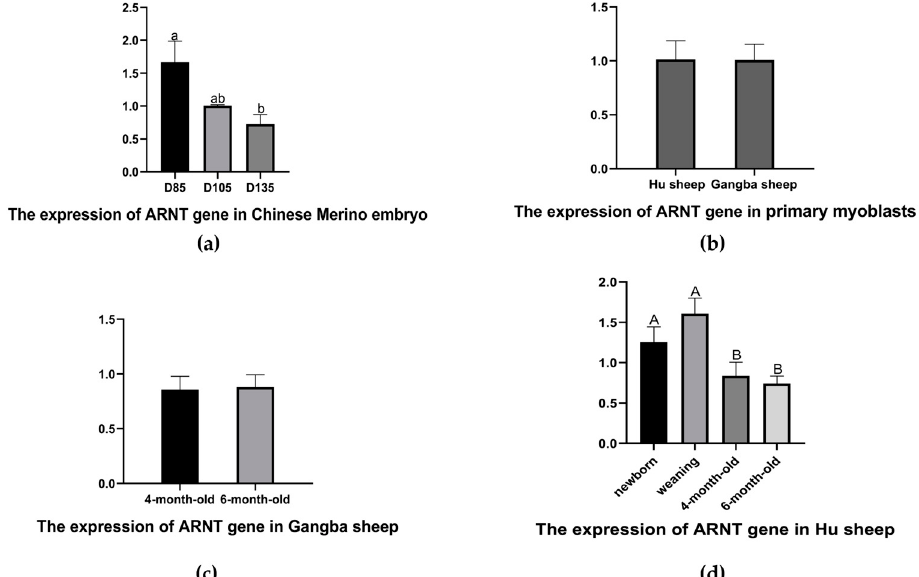
Figure 1. ARNT gene expression in muscle tissue of different breeds of sheep and primary myoblasts: ( a ) Chinese Merino sheep embryonic muscle tissues; ( b ) the expression of ARNT in Hu and Gangba sheep primary myoblasts; ( c ) The expression of ARNT in Gangba sheep muscle tissues; ( d ) The expression of ARNT in Hu sheep muscle tissues. Note: a and b indicate a significant difference ( p < 0.05), and A and B indicate an extremely significant difference ( p < 0.01).